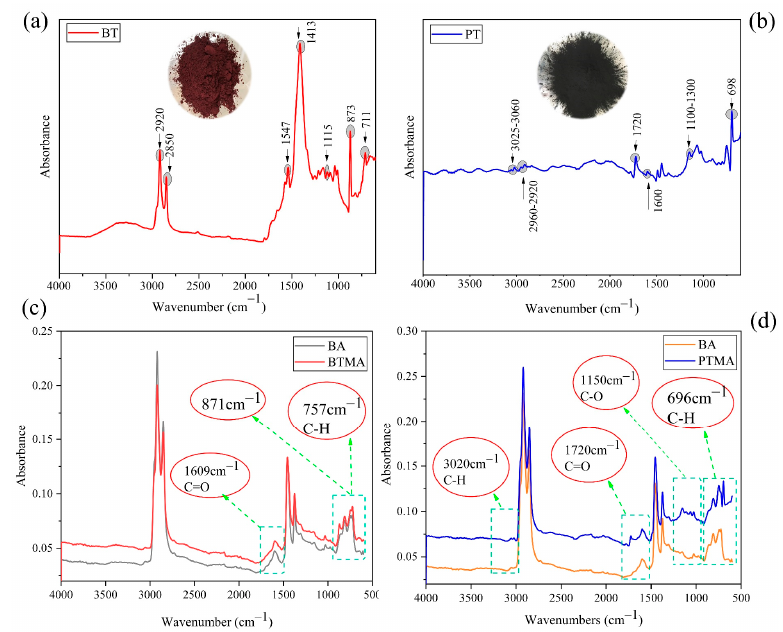
Molecules 2023 , 28 , x Figure 5. ATR ‐ FTIR spectrum of ( a ) BT, ( b ) PT, ( c ) BTMA, and ( d ) PTMA. Figure 5. ATR-FTIR spectrum of ( a ) BT, ( b ) PT, ( c ) BTMA, and ( d ) PTMA.